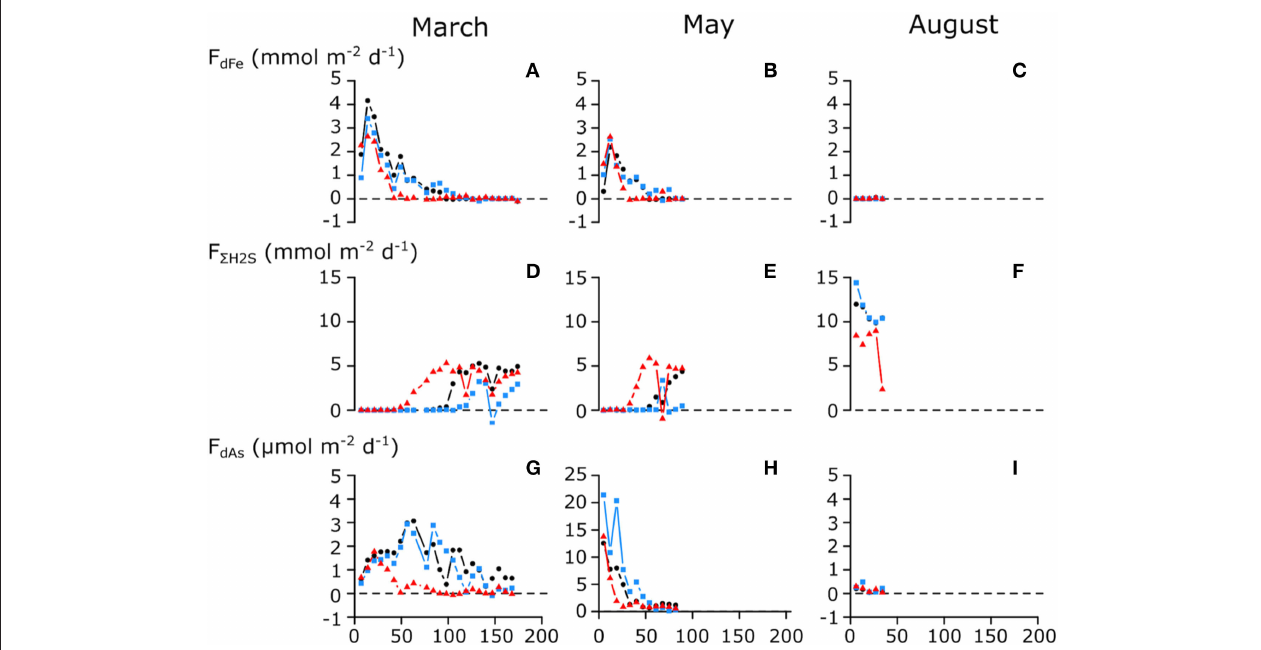
FIGURE 4 | Measured benthic fluxes of (A–C) dissolved Fe (dFe); (D–F) total free sulfide ( Σ H 2 S); and (G–I) dissolved As (dAs) during the long-term anoxic incubations of cores from seasonally hypoxic Lake Grevelingen. Incubations were stopped when Σ H 2 S was detected in the overlying water of all three cores. Cores were collected during different seasons; (A,D,G) March 2015; (B,E,H) May 2015; and (C,F,I) August 2015. Different colors indicate replicate cores. Note the difference in y-axis for the dissolved arsenic flux on (H) .